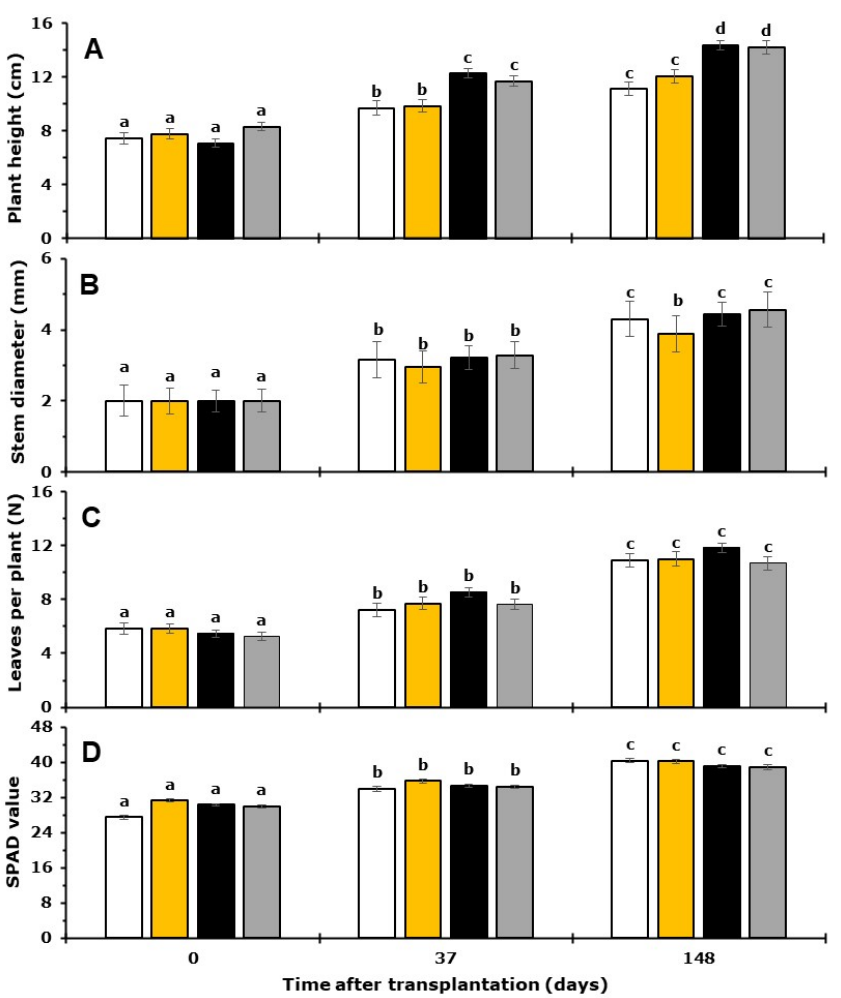
Figure 3. Height ( A ), stem diameter ( B ), number of leaves ( C ) and chlorophyll content ( D ) of Shoshoni and Shawnee seedlings inoculated with Tuber borchii ( ), T. melanosporum ( ) or T. aestivum ( ) and used as a control ( ) measured at the time of transplantation (0), after 37 and 148 days from transplantation. Each histogram represents the average of 13 plants ± standard deviation. Values with the same letter are not significantly different for the REGWQ test at p < 0.05. The greatest FW (from 74.4 to 79.7 g for plants inoculated with T. borchii and T. mel- anosporum , respectively) was recorded for the root systems of plants treated with the spore suspension of the three truffle species (Figure 4), while the smallest (about 34.9 g) was in the control plants. A similar pattern was recorded for the shoots (Figure 4). The control plants (13 g) had the lowest shoot dry mass. The greatest dry mass (25.5 g) was measured in plants inoculated with T. aestivum (Figure 4). No significant differences were recorded between the two tested cultivars.